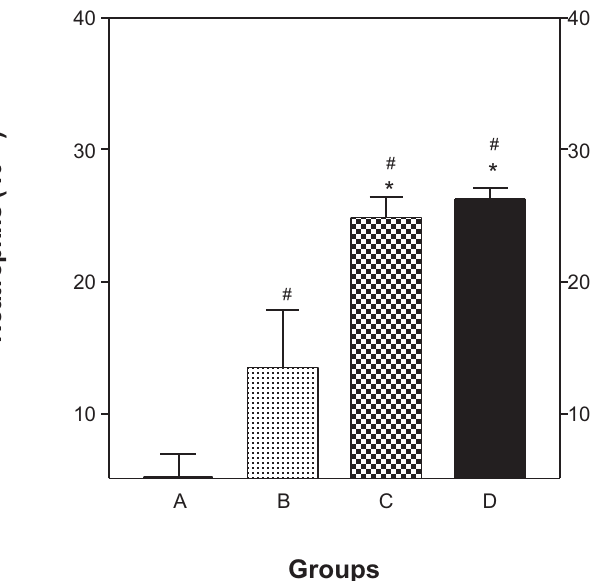
FIGURE 5 – Relative number of neutrophils/mg lung tissue after 30 min of segmental liver ischemia and 30 min of reperfusion group A (n=8, control): laparotomy and manipulation of the liver pedicle; group B (n=8): laparotomy and 30 min occlusion of the vascular liver pedicle, followed by reperfusion for 30 min; group C (n=8): HO therapy at 2.5 ATA for 60 min, laparotomy, 30 min occlu- sion of the vascular liver pedicle, followed by reperfusion for 30 min; group D (n=8): exposure to ambient air at 2.5 ATA for 60 min, laparotomy, and 30 min occlusion of the vascular liver pedicle, followed by reperfusion for 30 min. The columns represent the mean ± standard deviation. * (p < 0.05) compared to groups A and B. # (p < 0.05) compared to group